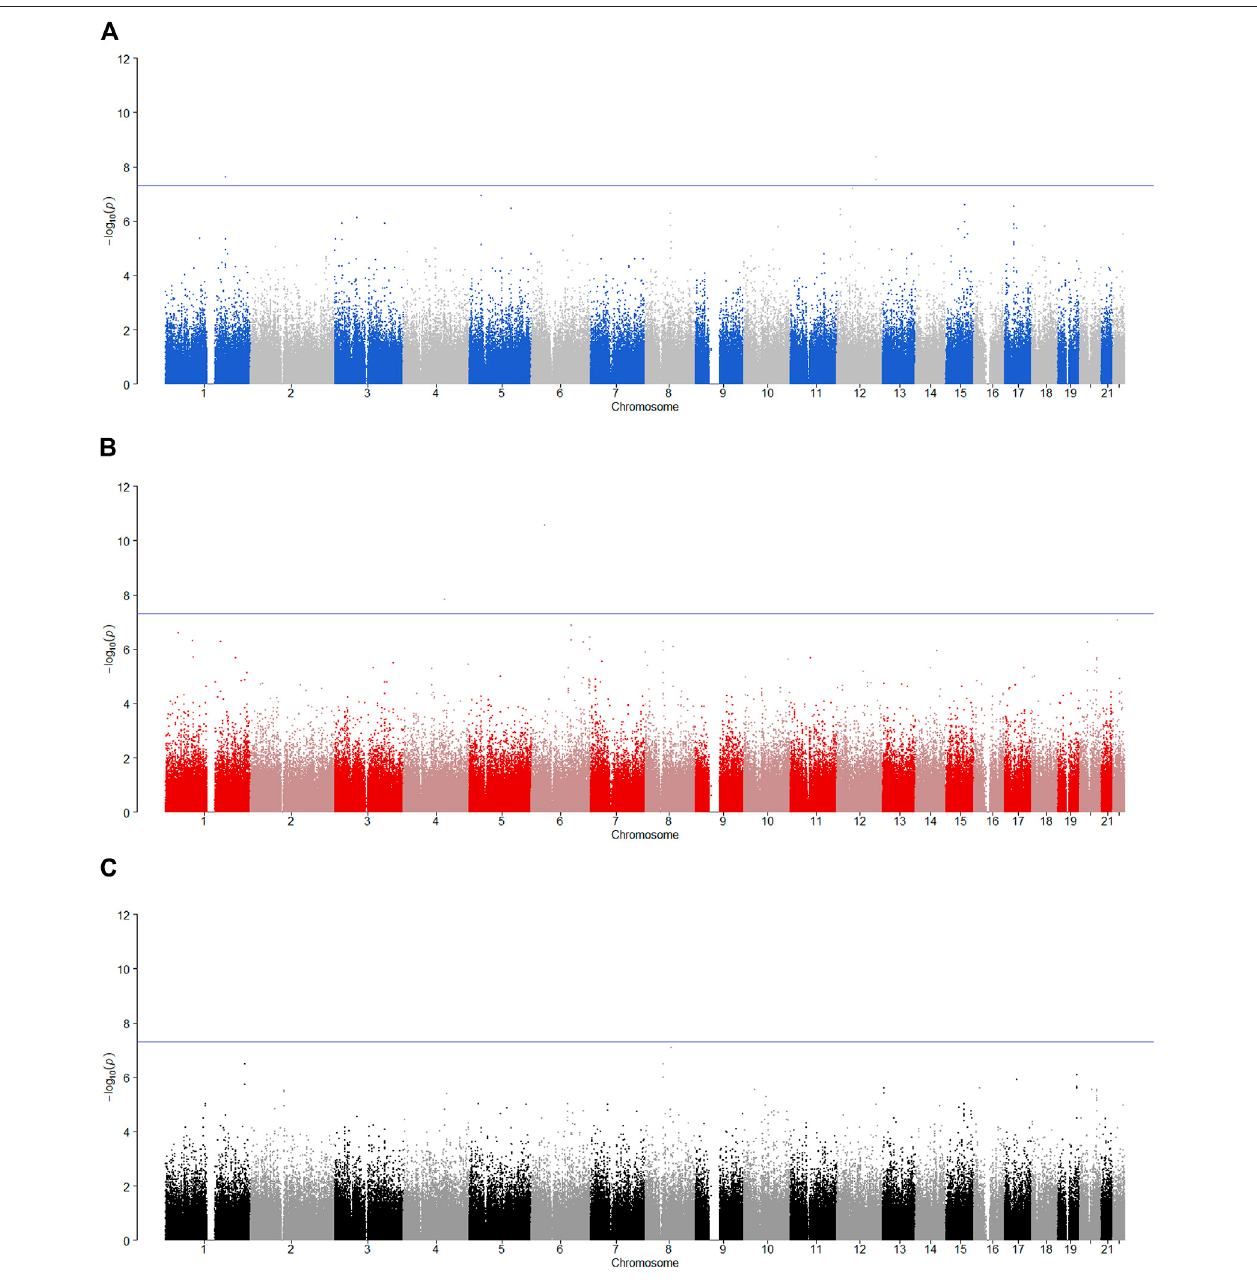
FIGURE 4 | Manhattan plot for POE and genotypic effect tests of alcohol dependence ( N = 2,185). The blue line represents the signi fi cance level α (cid:1) 5 × 10 − 8 , which is the signi fi cance level of GWAS. Note that three SNPs on Chromosome 6 are overlapped. (A) Paternally derived effect, (B) maternally derived effect and (C) genotypic